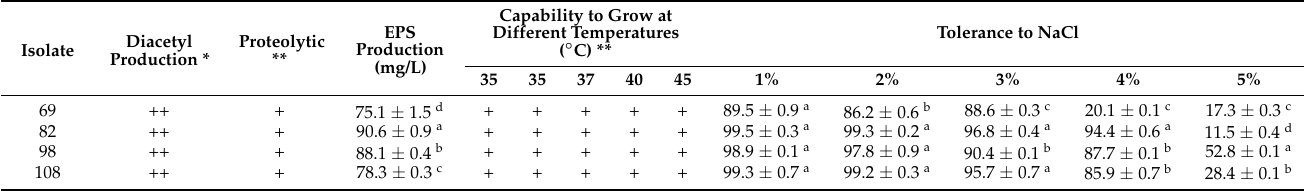
Table 2. Results of in vitro tests to measure the technological properties of lactic acid bacteria isolates from xique-xique cladodes and fruit selected as having the most promising probiotic-related characteristics.